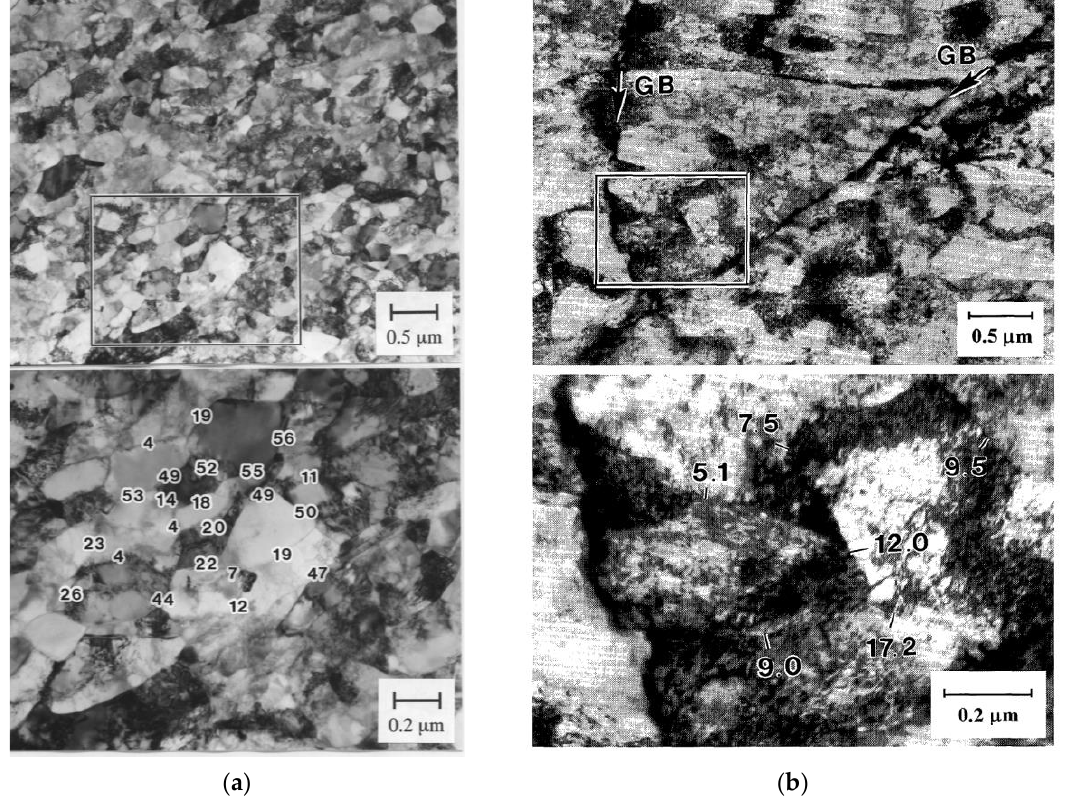
Figure 25. TEM images of deformation microstructures after multiple forging to total strains of 1.6 at 873 K of a 305-type stainless steel with initial grain size of 1.5 μ m ( a ) [97] and 15 μ m ( b ) [93]. Reproduced from [97] with permission from Elsevier, 2023. The numbers indicate the boundary misorientations in degrees.